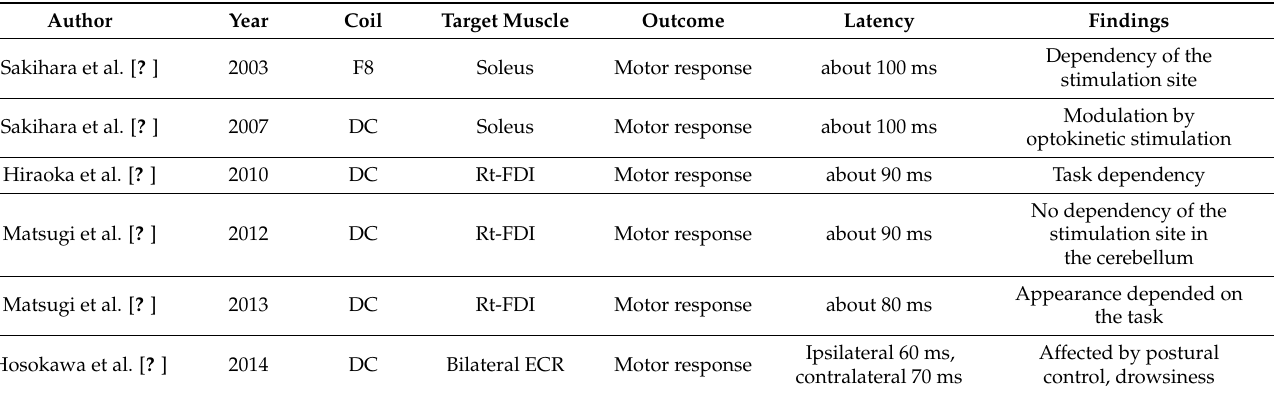
Table 1. Studies of cerebellar TMS and motor